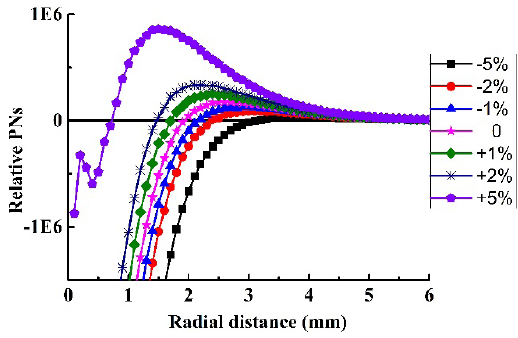
Fig. 6. The FRPs with light source drift errors by